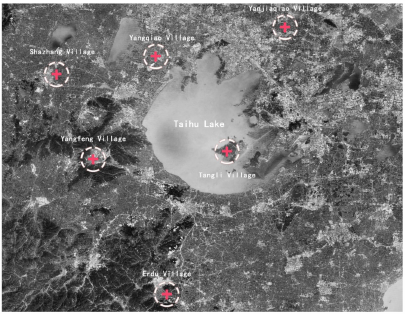
Figure 1. Distribution of typical traditional villages around Taihu